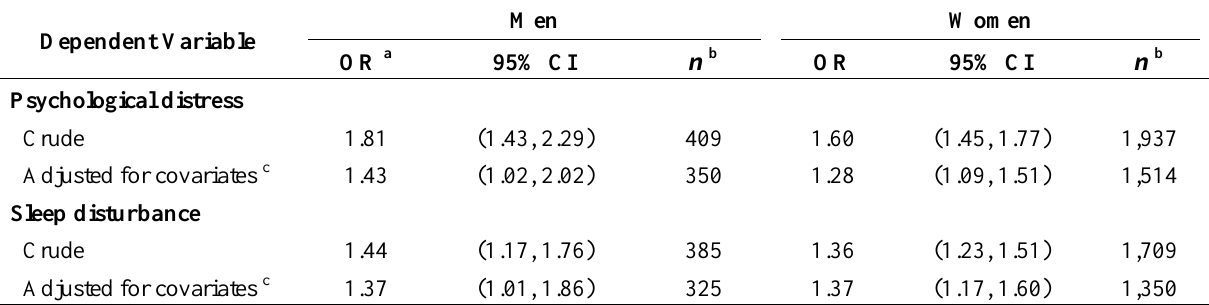
Table 4. Associations of sense of contribution with poor mental